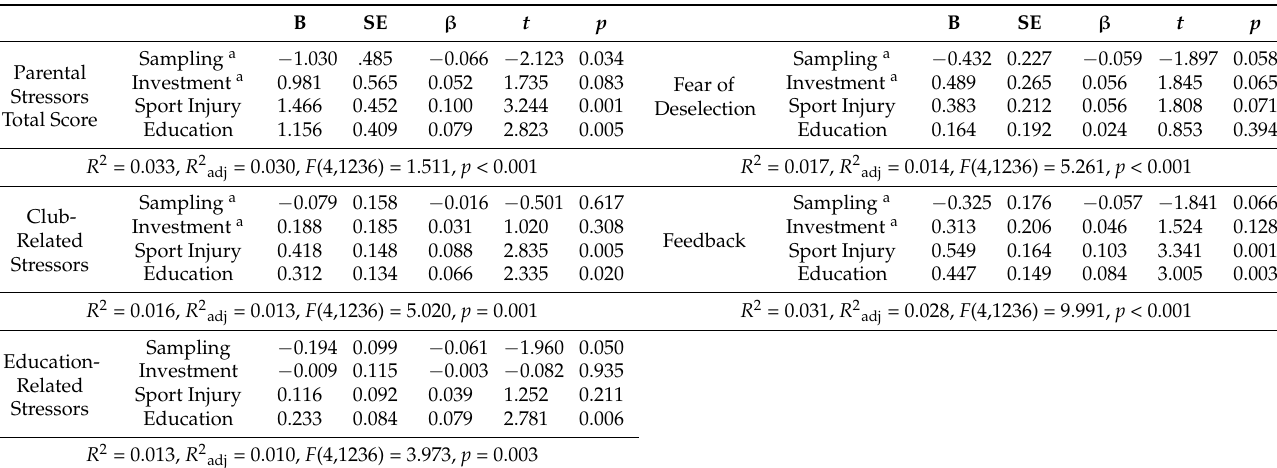
a Predictor: Child’s sport participation stage (dummy variable; excluded category: